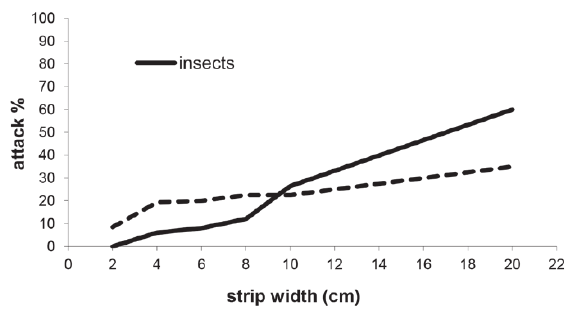
Figure 5 - Percentage of insect and disease attacks in Drimys brasiliensis measured on different widths of